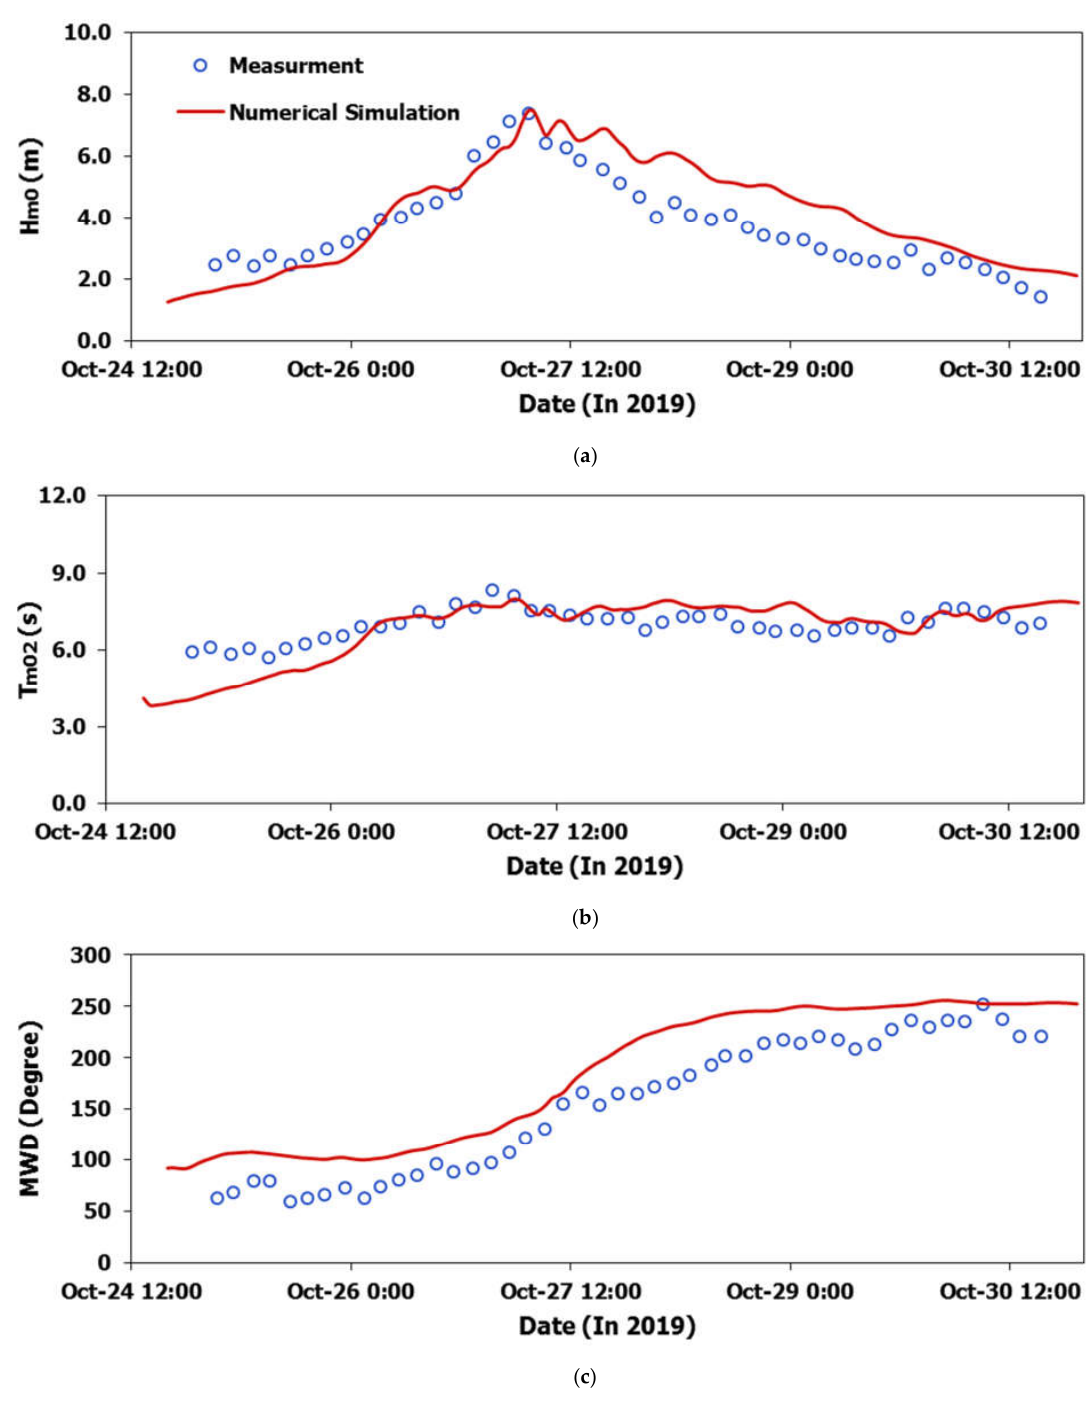
Figure 7. Comparison of the ( a ) wave height and ( b ) wave period ( c ) wave direction from simulation and measurement data during tropical cyclone Kyarr.